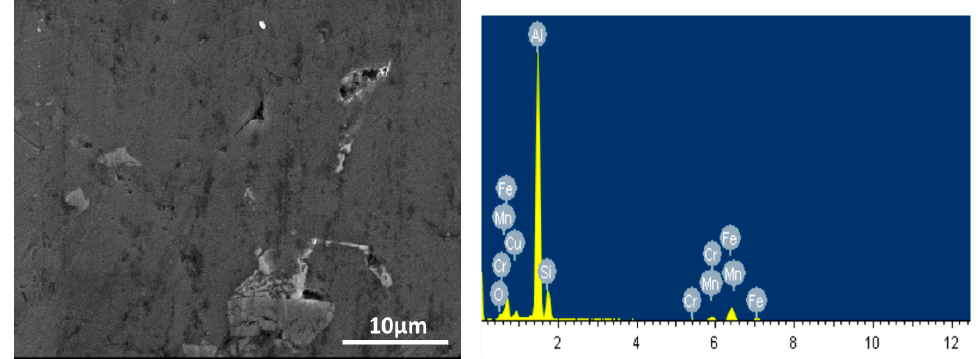
Figure 1. SEM (at 2000×) and EDS images of base Al-Mg-0.6Si-0.35Fe alloy matrix.